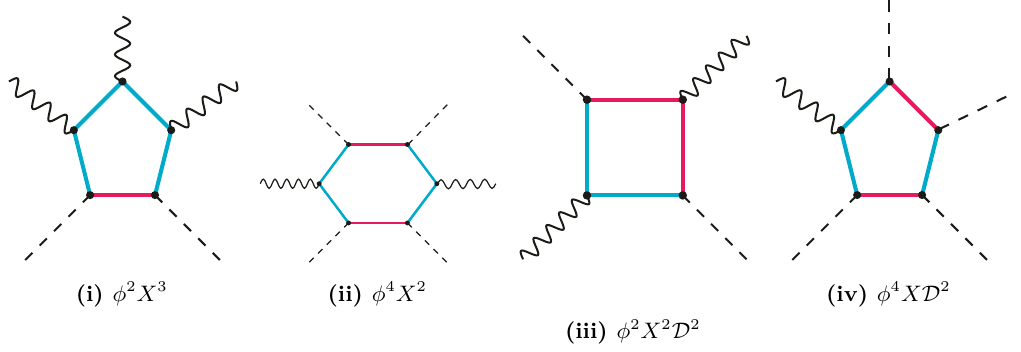
Figure 10. Schematic diagrams revealing heavy-heavy fermion mixing incorporated within (i) φ 2 X 3 , (ii) φ 4 X 2 , (iii) φ 2 X 2 D 2 , and (iv) φ 4 X D 2 classes of SMEFT